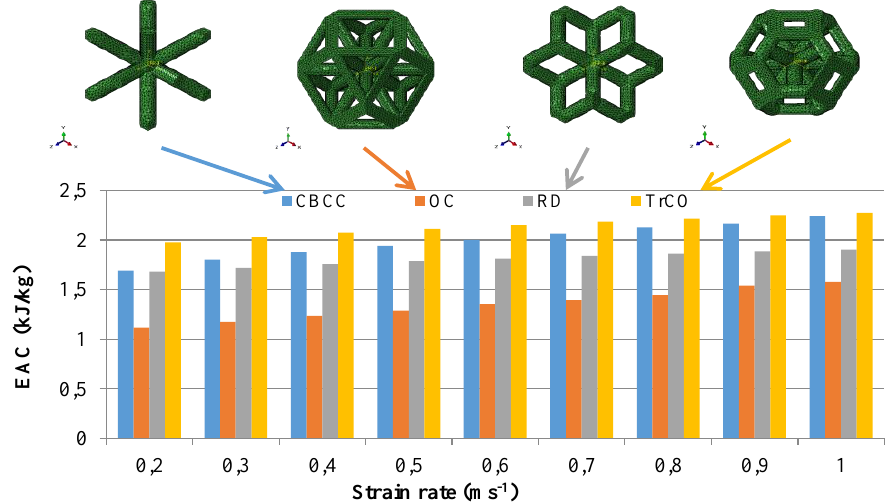
Fig. 1. Preliminary EAC assessment of different geometries for a strain 𝜀 0 =